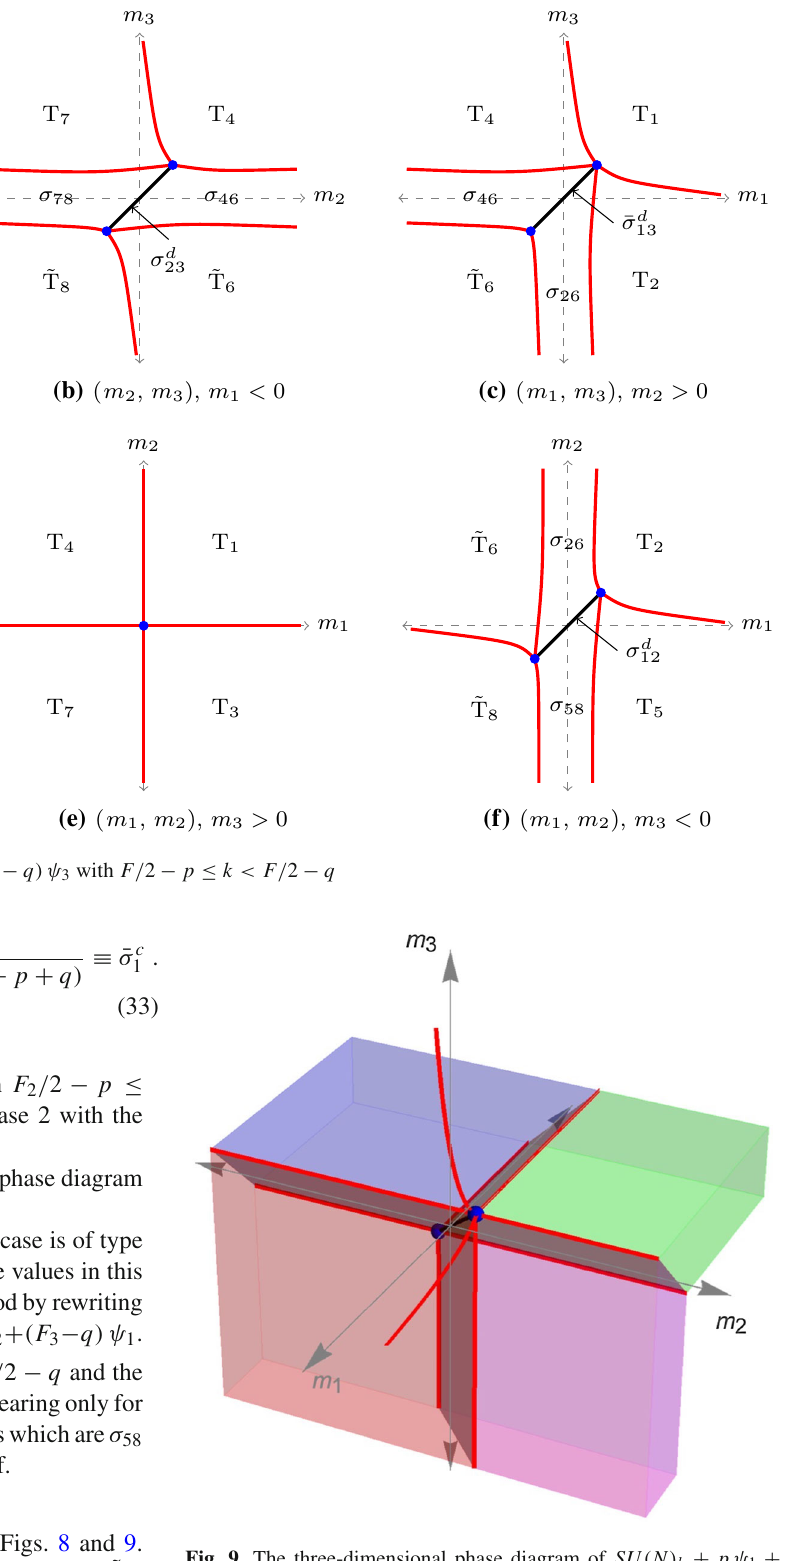
Fig. 9 The three-dimensional phase diagram of SU ( N ) k + p ψ 1 + the region in magenta color and ˆ σ c is represented by the green 3